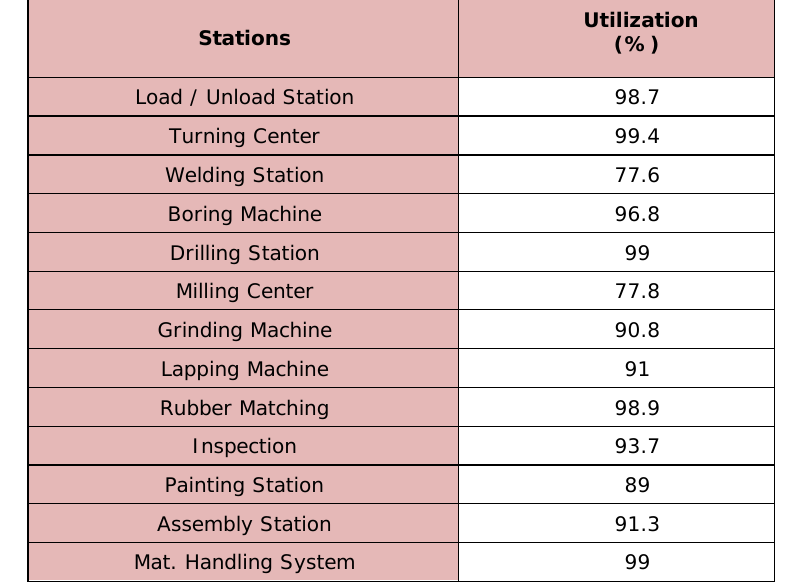
Table 6. “Increased Station Utilization in proposed FMS”. Source: Own contribution